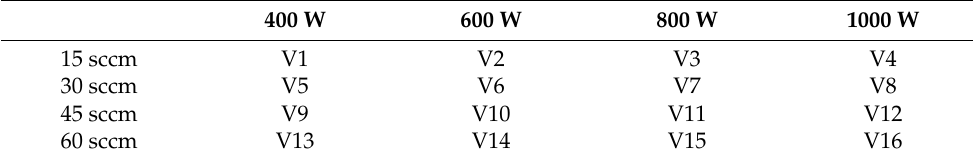
Table 3. Experimental parameters of cross-verification experiment V1–V16.